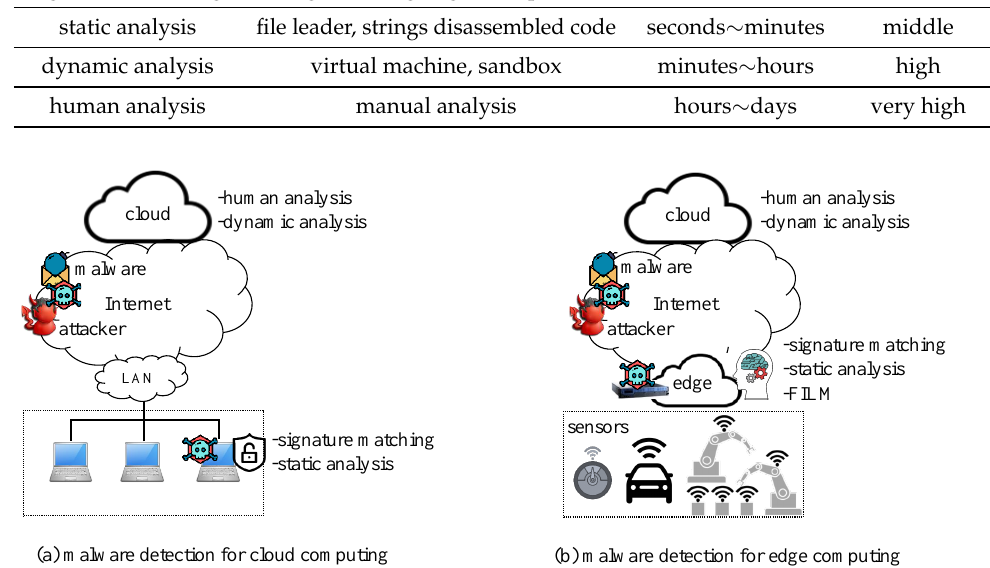
Figure 1. Comparison of machine-learning-based malware detection for ( a ) cloud computing and ( b ) edge